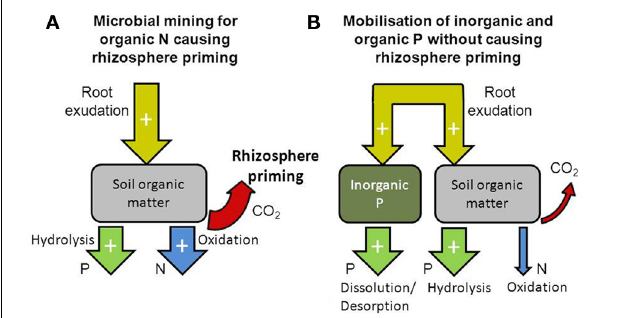
FIGURE 2 | Diagram illustrating how the availability of nitrogen and phosphorus in the soil can influence rhizosphere priming. When nitrogen availability is low, microbes utilize rhizodeposition to mine for nitrogen locked in organic matter thereby increasing rhizosphere priming and release of nitrogen (through oxidation of SOM) and phosphorus [mostly through hydrolysis of P-esters in SOM, (A) ]. When phosphorus availability is low, rhizodeposition is utilized to mobilize phosphorus from inorganic and organic sources (through dissolution/desorption and hydrolysis, respectively) thereby increasing the release of phosphorus without affecting rhizosphere priming (B)